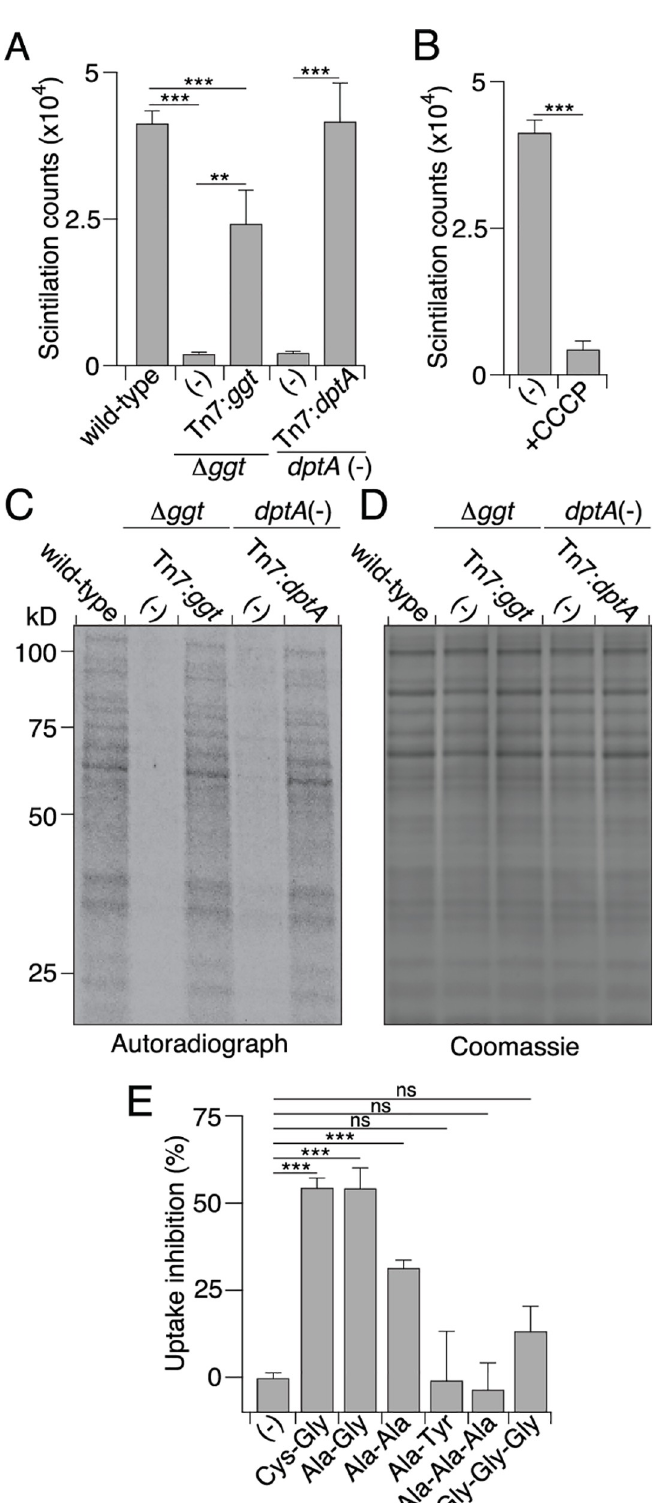
Fig 3. DptA is the sole Cys-Gly transporter in LVS. (A-B) Quantification of the intracellular levels of 3 H-GSH byproducts after 45 min incubation with the labeled substrate in the indicated strains of LVS (A) or WT LVS with and without CCCP (B). (C) Autoradiograph of SDS-PAGE separated proteins produced by growing the indicated strains